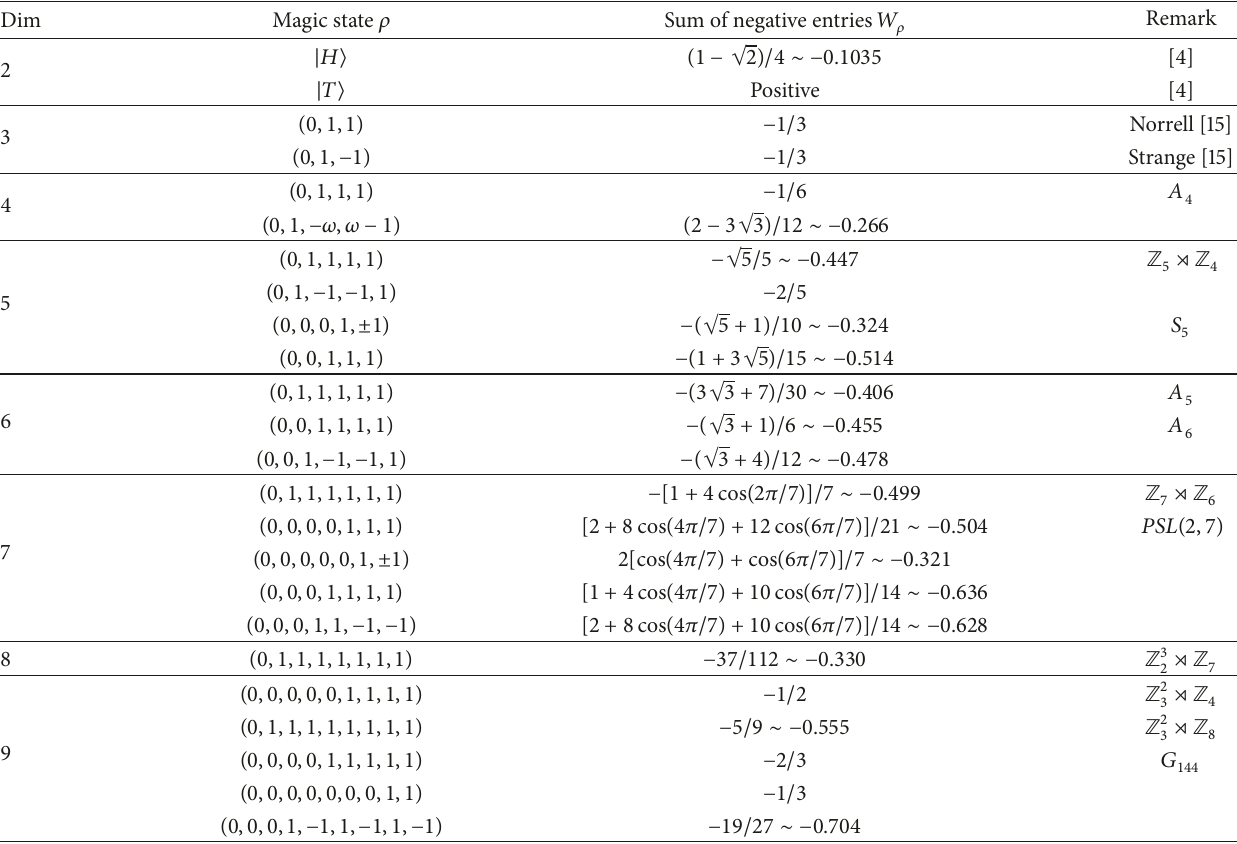
Table 2: The magic states 𝜌 (column 2) and the sum of negative entries in the Wigner matrix 𝑊 𝜌 (column 3). For 𝑑 > 3 , column 4 provides the permutation group under consideration. The group 𝐺 144 is isomorphic to Z 2 3 ⋊ ( Z 2 ⋊ 𝐷 4 ) , where 𝐷 4 is the eight element dihedral group. Dim Magic state 𝜌 Sum of negative entries 𝑊 𝜌